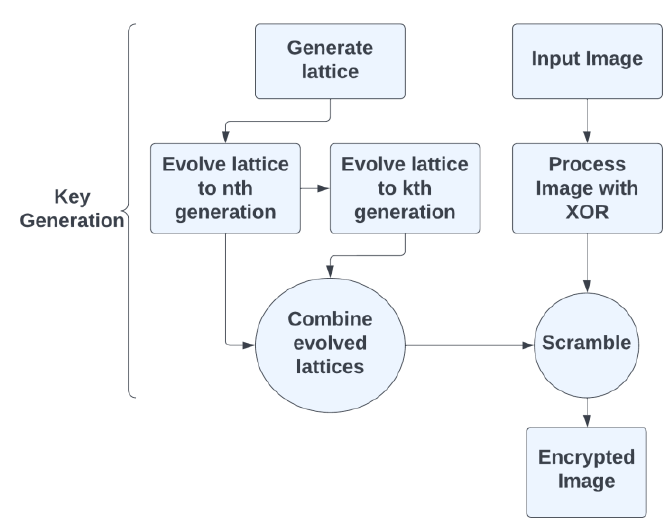
Figure 3. An illustration of main steps of proposed image encryption scheme.